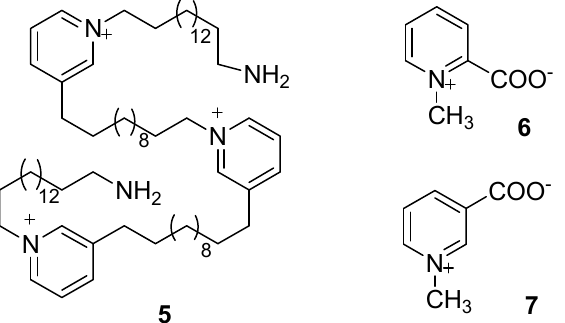
Figure 3. Chemical structures of pachychaline C ( 5 ), homarine ( 6 ) and trigonelline ( 7